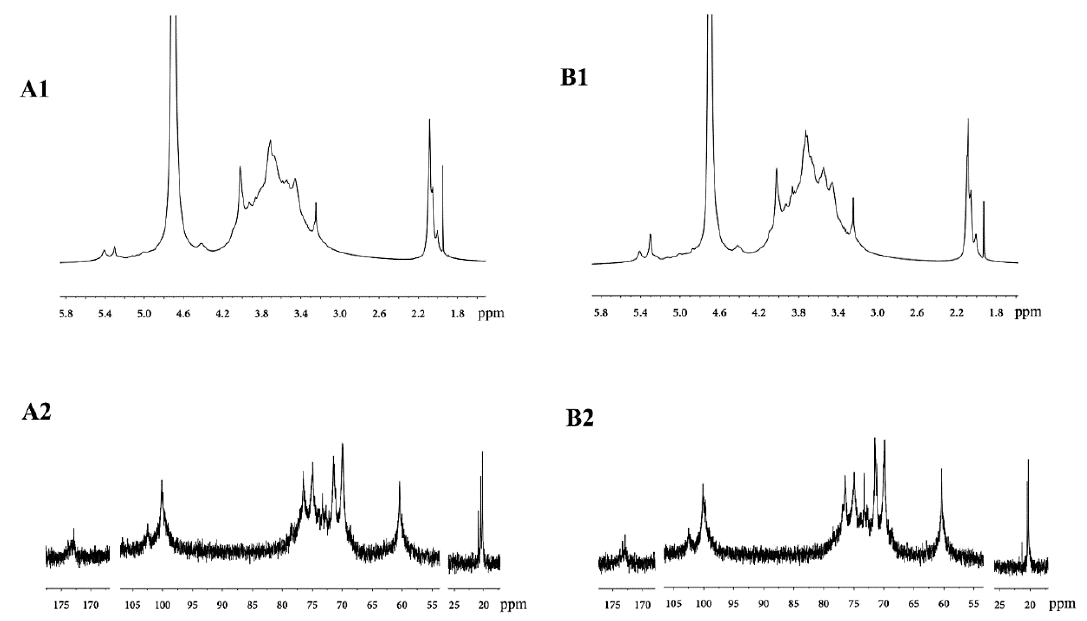
Figure 3. 1 H- and 13 C-NMR spectra of DOPA-1( A1 , A2 ) and DOPA-2 ( B1 , B2 ).